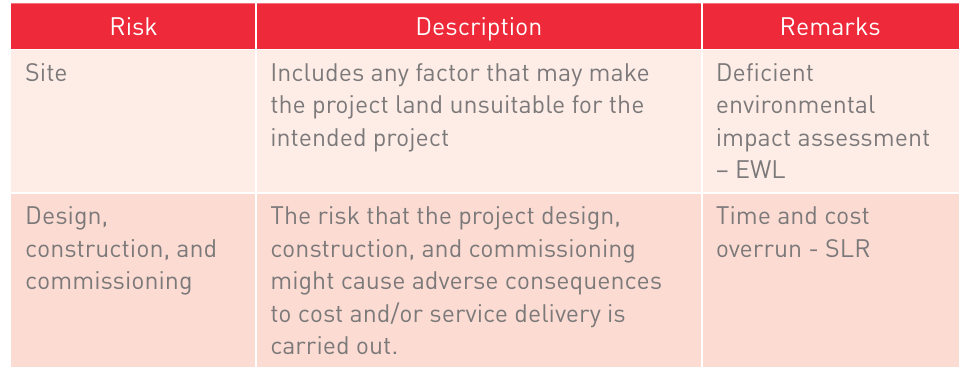
Selected project risks and their description (Commonwealth of Australia, 2008)